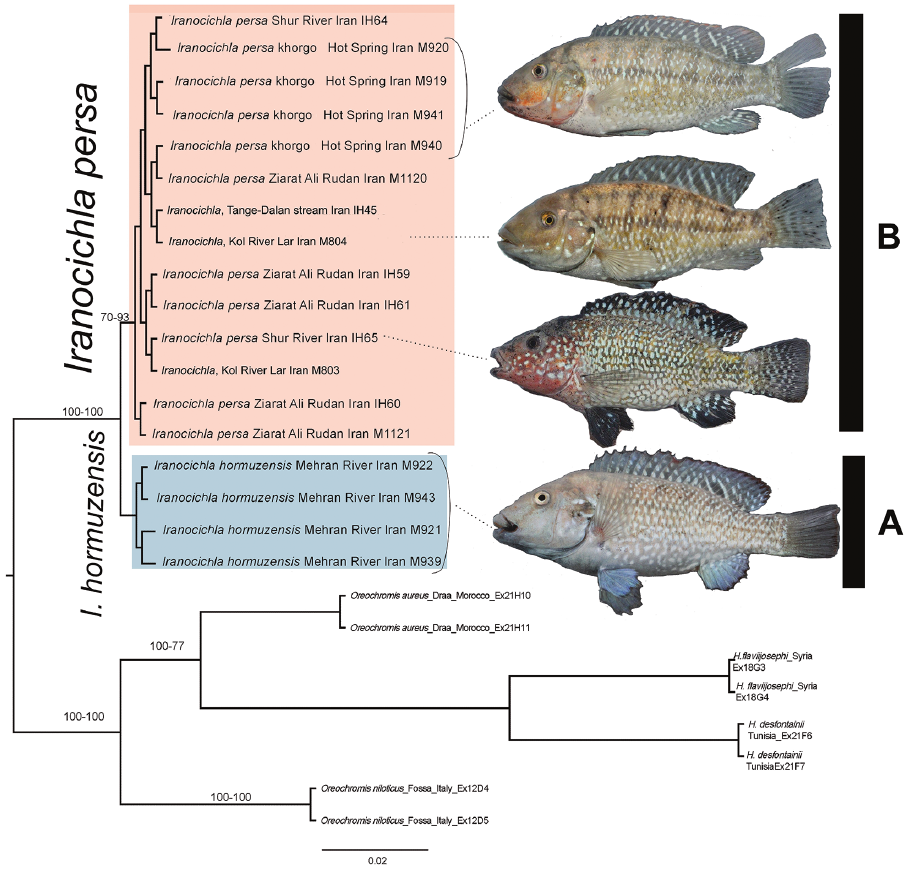
Figure 2. Maximum Likelihood estimation of the phylogenetic relationships of Iranocichla species based on the mitochondrial COI barcode region. Nucleotide positions with less than 95% site coverage were eliminated before analysis. Numbers of major nodes indicate bootstrap values from the Maximum Likeli- hood-method from 1000 pseudo-replicates, followed by Bayesian posterior